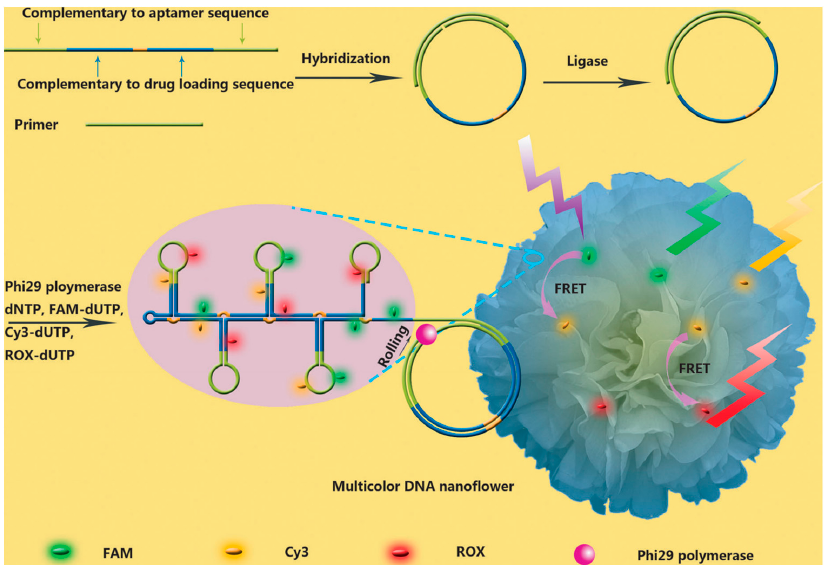
Figure 2. Schematic illustration of aptamer-conjugated DNA nanoflowers (NFs) by rolling circle replication reaction (RCA) to realize cellular imaging with fluorescent resonance energy transfer (FRET) for tracking DOX drug. Reprinted with permission from © (2014) WILEY-VCH Verlag GmbH & Co. KGaA